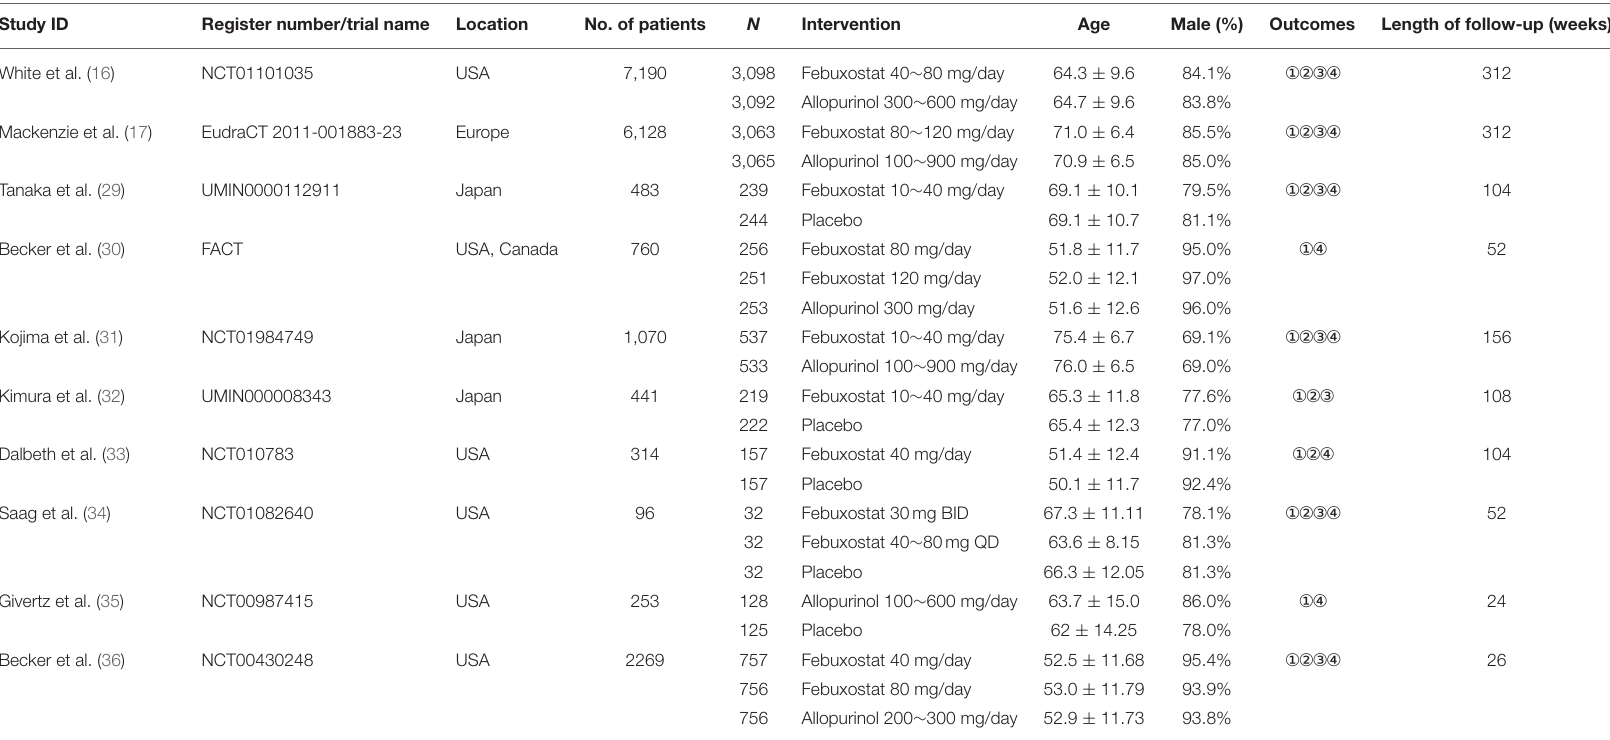
TABLE 1 | Characteristics baseline of randomized controlled